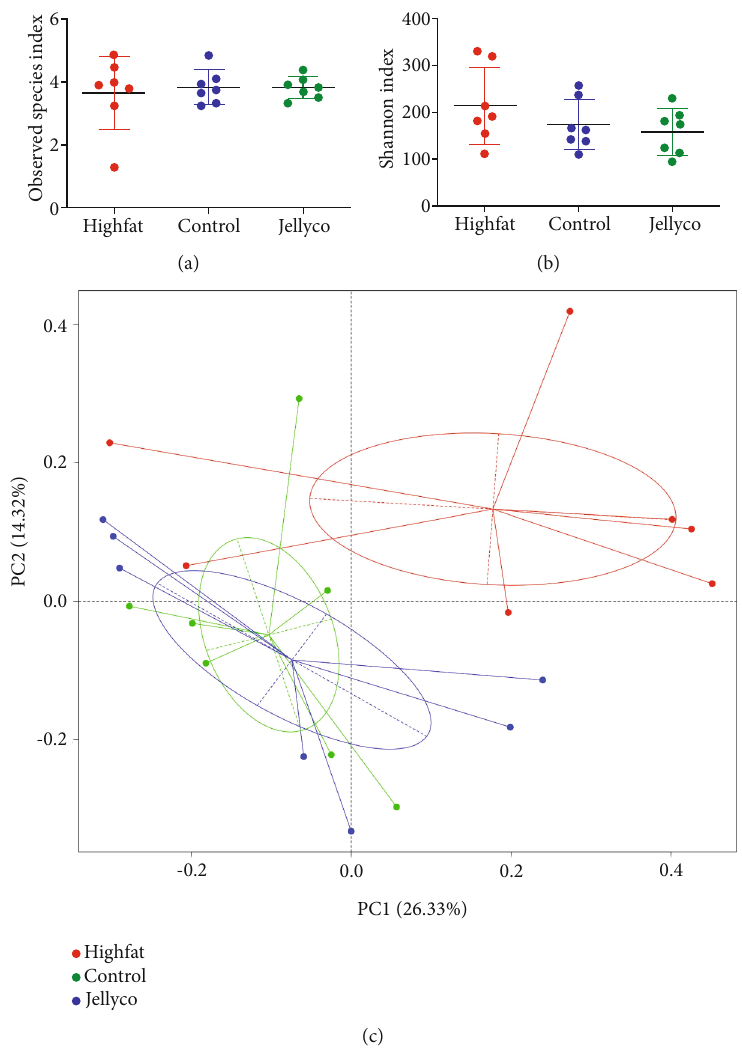
Figure 5: E ff ects of jelly fi sh collagen hydrolysate on α - and β -diversity in cecal microbiota in high-fat diet-fed mice: (a) observed species index, (b) Shannon index, and (c) PCoA analysis based on unweighted UniFrac distance. Data are expressed as means ± SEM , n = 7